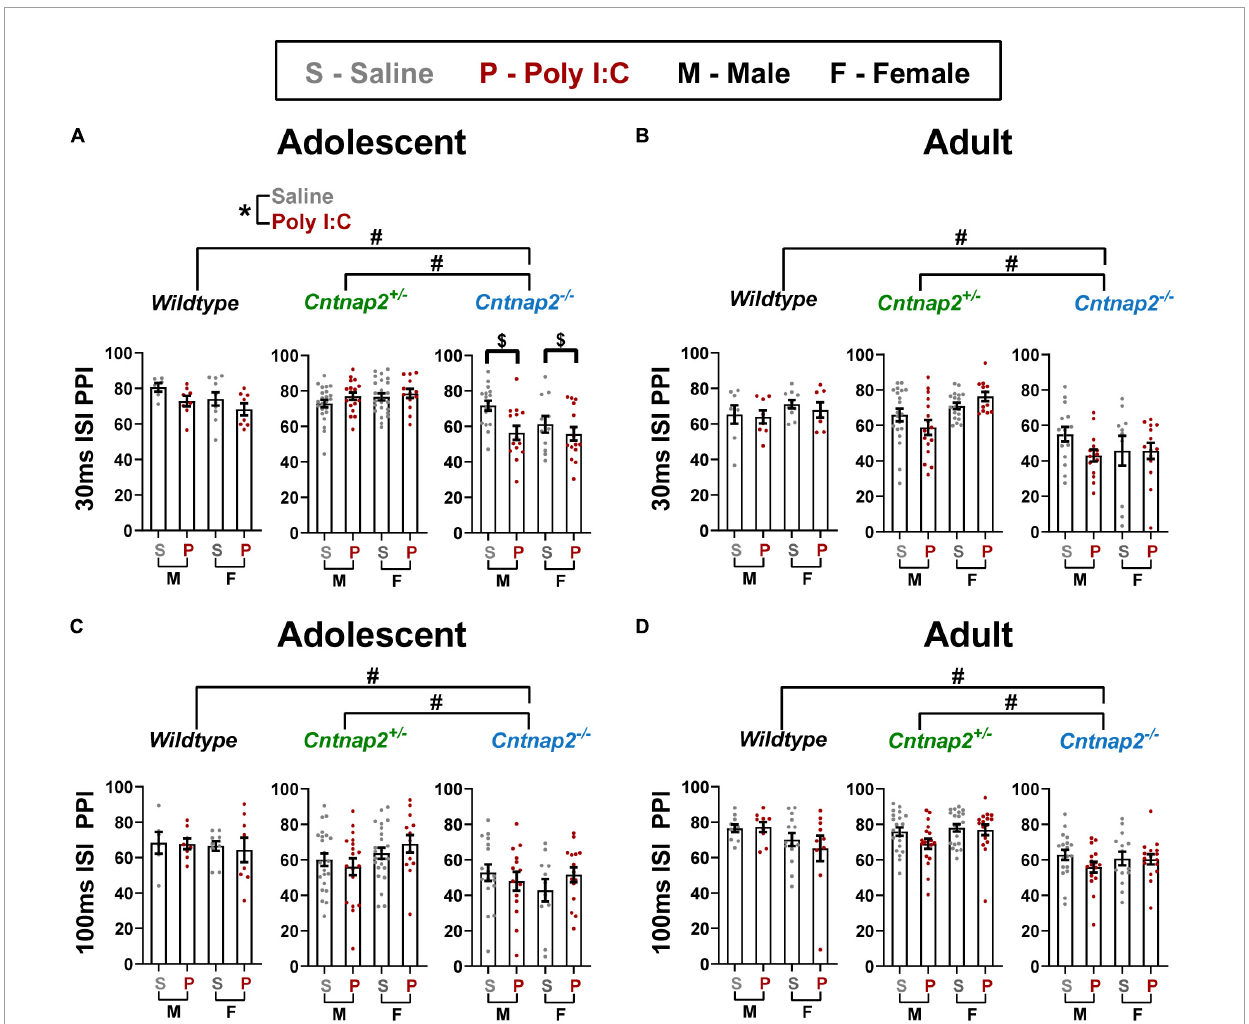
FIGURE5 Cntnap2 deficiency impairs PPI at all stimulus parameters, but Poly I:C MIA leads to further reduction in PPI in Cntnap2 − / − adolescent offspring with 30 ms ISIs. (A) Adolescent Cntnap2 − / − offspring show significantly reduced PPI at 30 ms ISI compared to both WT and Cntnap2 + / − animals (adjusted p < 0.001; indicated by the # symbol), and Poly I:C MIA leads to further reduction of PPI in an independent manner across all genotypes ( p = 0.013; indicated by the ∗ symbol) and in a synergistic manner in Cntnap2 − / − males ( p = 0.003; indicated by the $ symbol). (B) In adulthood, Poly I:C MIA has no influence on PPI, but Cntnap2 − / − offspring still show greatly reduced PPI at 30 ms ISI (adjusted p < 0.001; indicated by the # symbol). (C,D) At 100 ms ISI, Cntnap2 − / − offspring show reduced PPI in both adolescence and adulthood ( p < 0.001; indicated by the # symbol) and Poly I:C MIA does not influence PPI in any of the genotype groups. Data are shown as mean ± standard error. For information on sample sizes for each group, please see Table 1